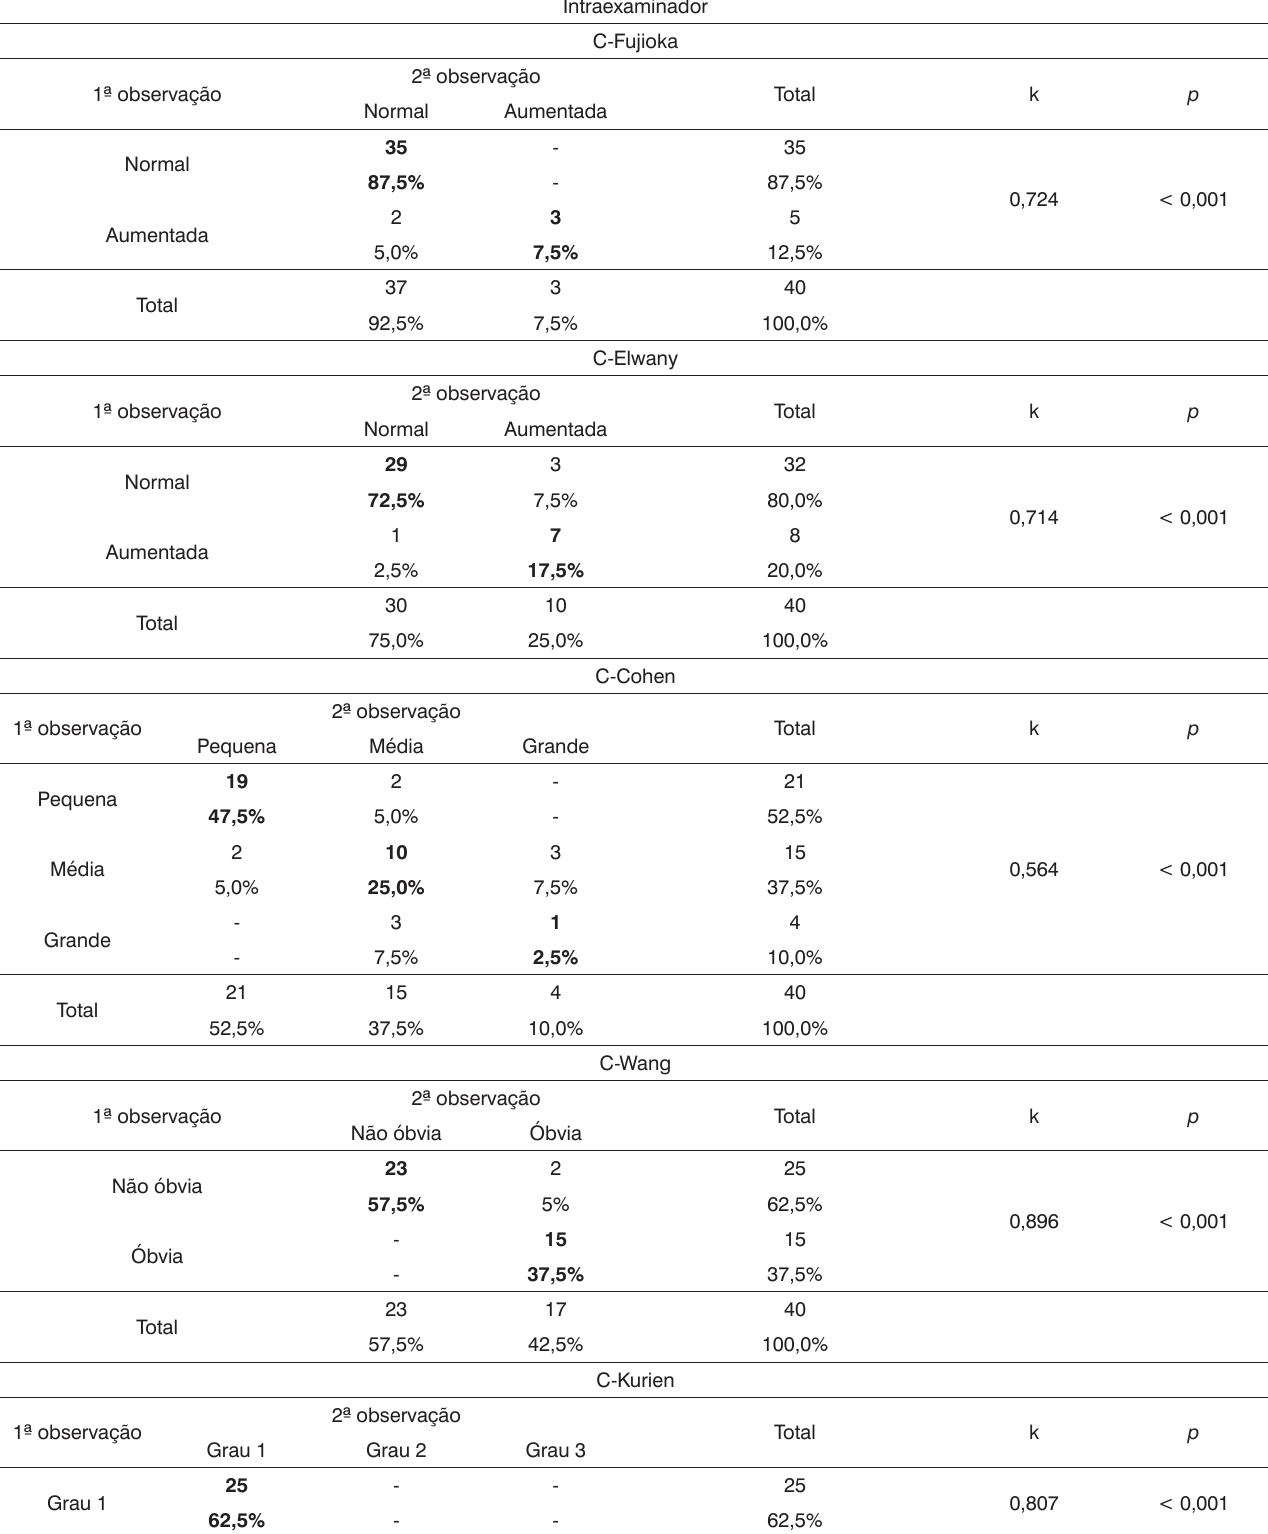
Tabela 5. Coeficiente kappa (k) dos parâmetros radiográficos categóricos de RC em relação à primeira e segunda observações do Examinador 1 (análise intraexaminador), e entre os Examinadores 1 e 2 (análise